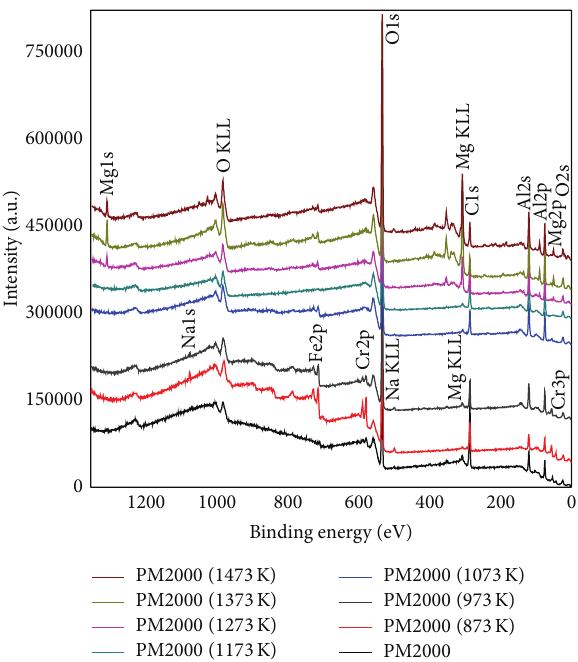
Figure 7: XPS survey spectra of as-received and oxidized PM2000.